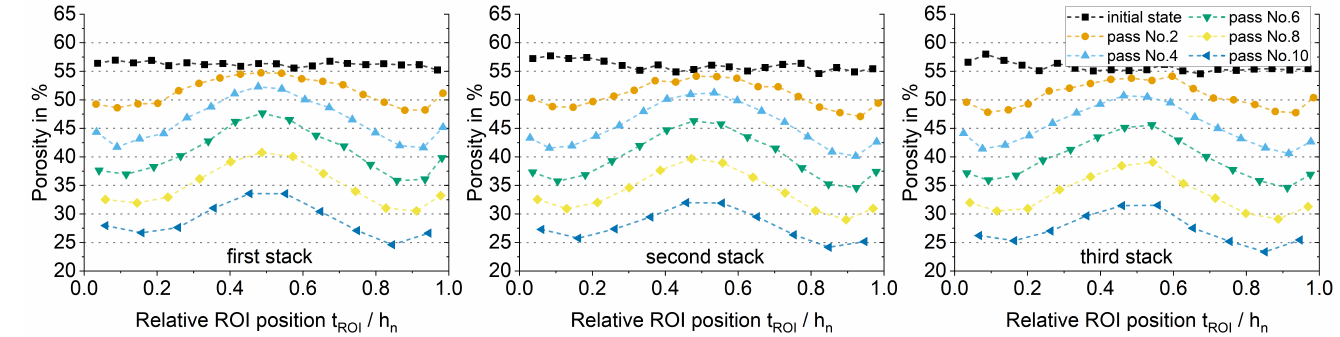
Figure 13. Series I: 20-0.50-10 ( l d / h m ≈ 0.7 − 0.8): Porosity change over relative sample depth (0=upper surface; 0.5= mid-section of sample; 1=lower surface) due to rolling for first, second and third